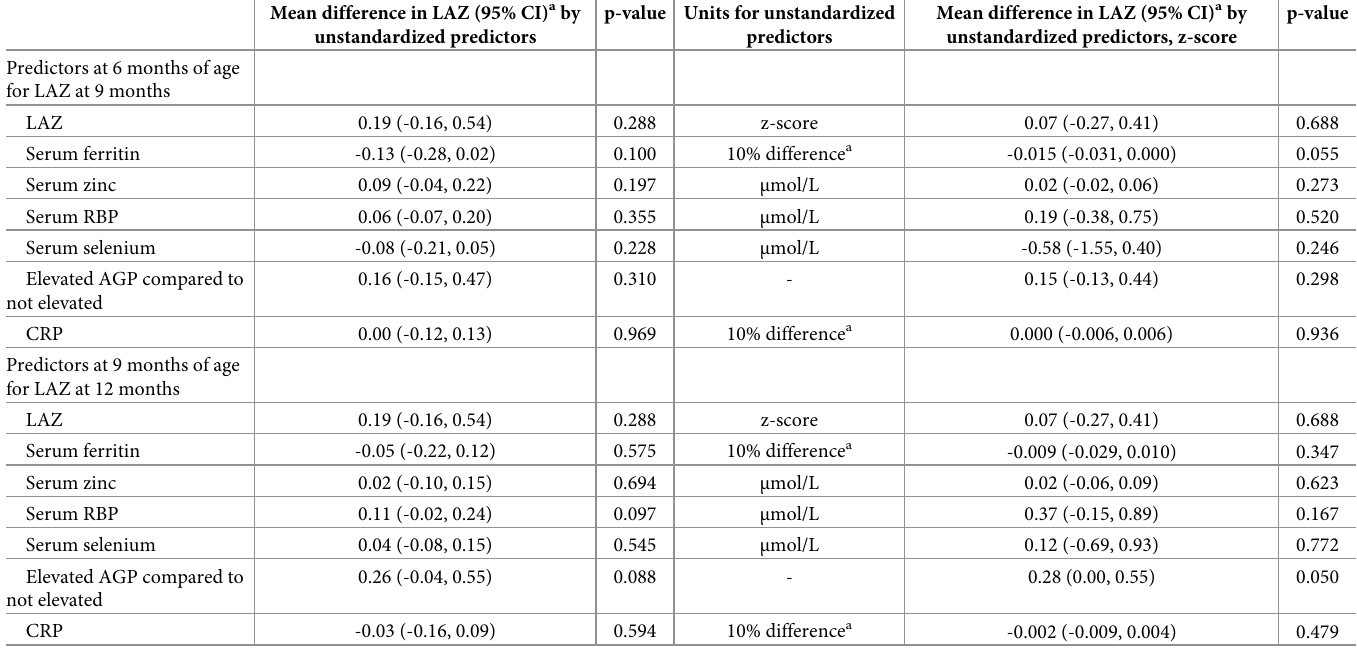
Table 6. Micronutrient and systemic inflammation biomarker predictors of length-for-age z-score (LAZ) at 6 and 9 months and 9 and 12 months of age (n = 225). p-value Units for unstandardized Mean difference in LAZ (95% CI) a by unstandardized predictors